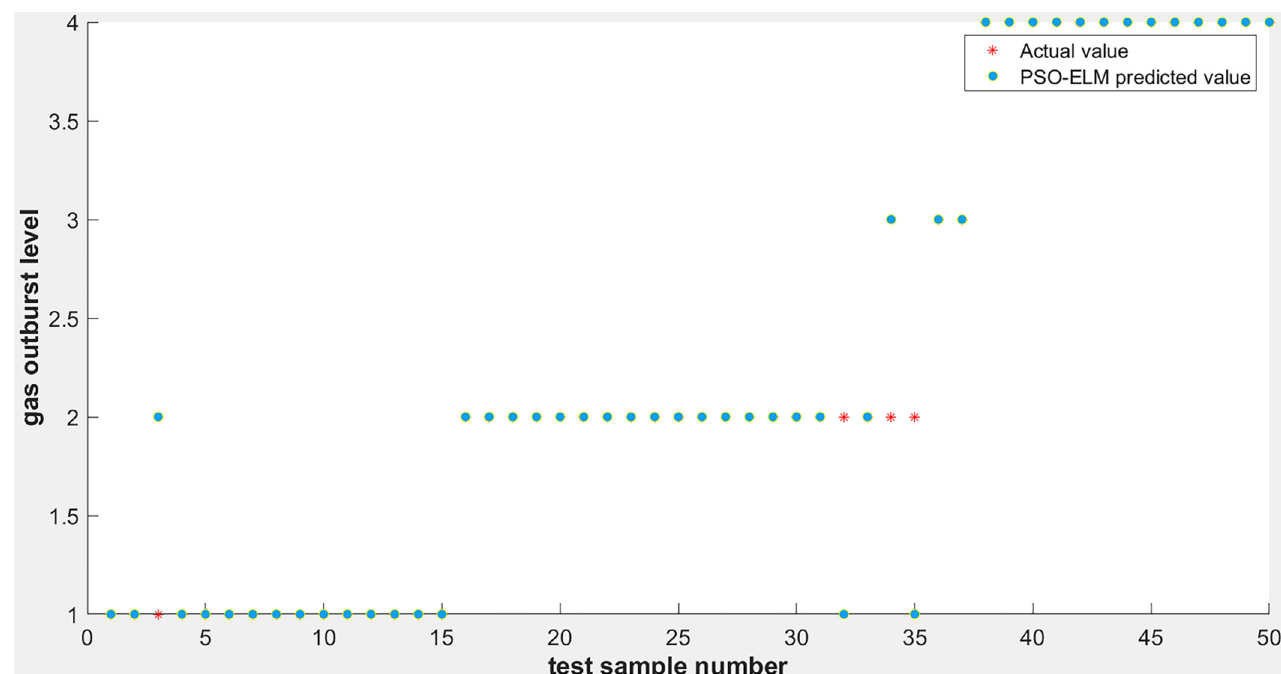
Figure 5. PSO-ELM model simulation output results.